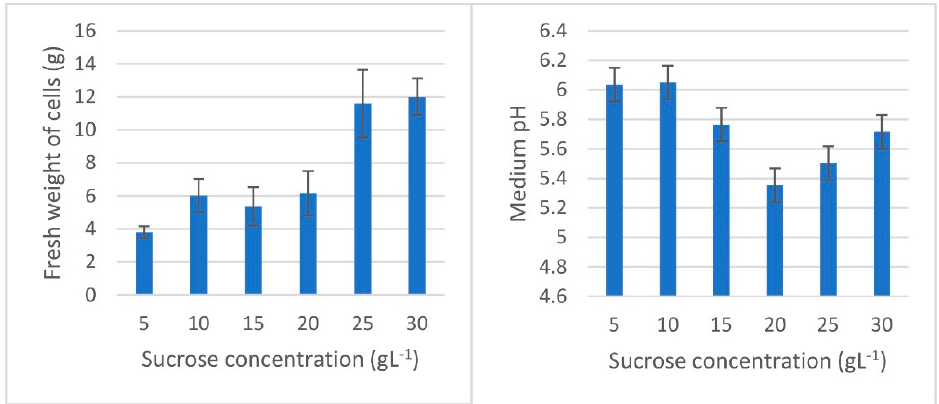
Figure 5. Fresh weights and medium pH of L. schweinfurthii cell cultures after 2 weeks of culture on 50 mL MS medium fortified with 2 mg L − 1 NAA. Inoculation weight was 1 g fresh callus per 50 mL liquid medium. Four replicates were used for each sucrose concentration.